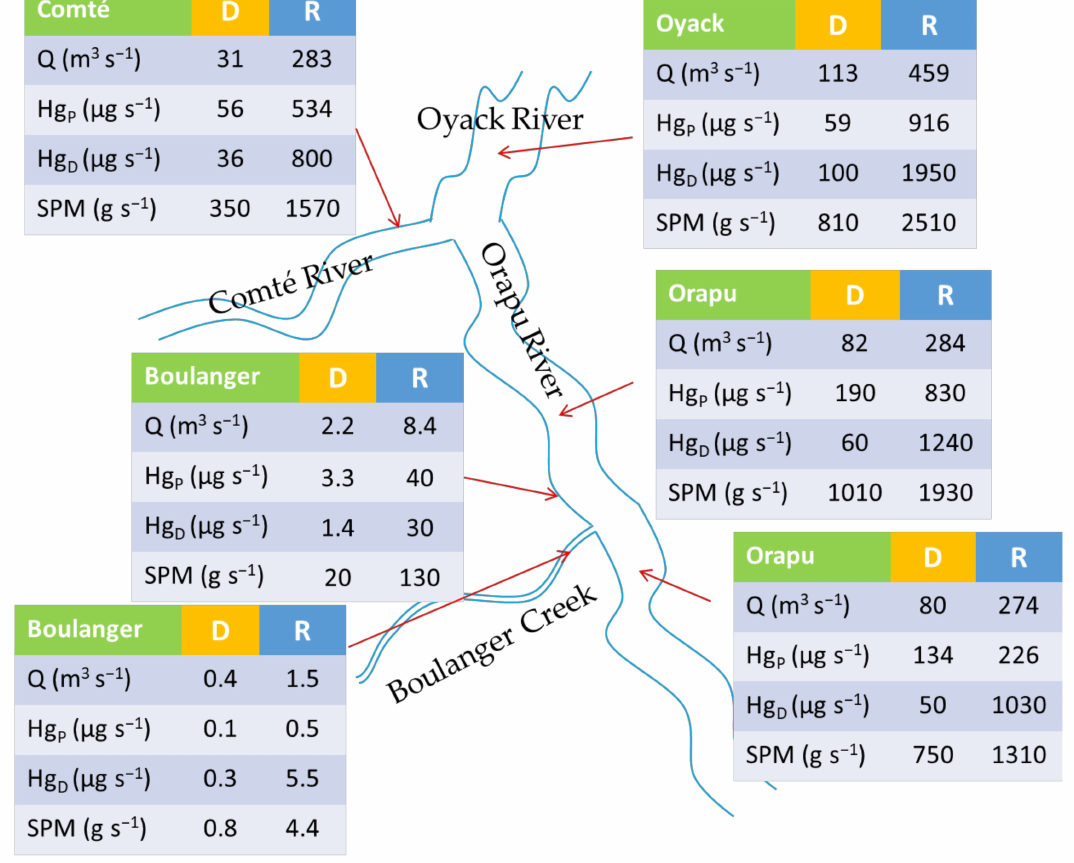
Figure 6. Comparison of water flux in the Orapu-Comt é watershed and associated estimations of SPM and Hg export during the dry and rainy sampling campaigns (September 2012 and March 2013), (dry season (D); rainy season (R); particulate Hg (Hg P ); dissolved Hg (Hg D